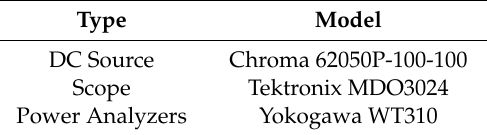
Table 2. Equipment of the experimental platform.